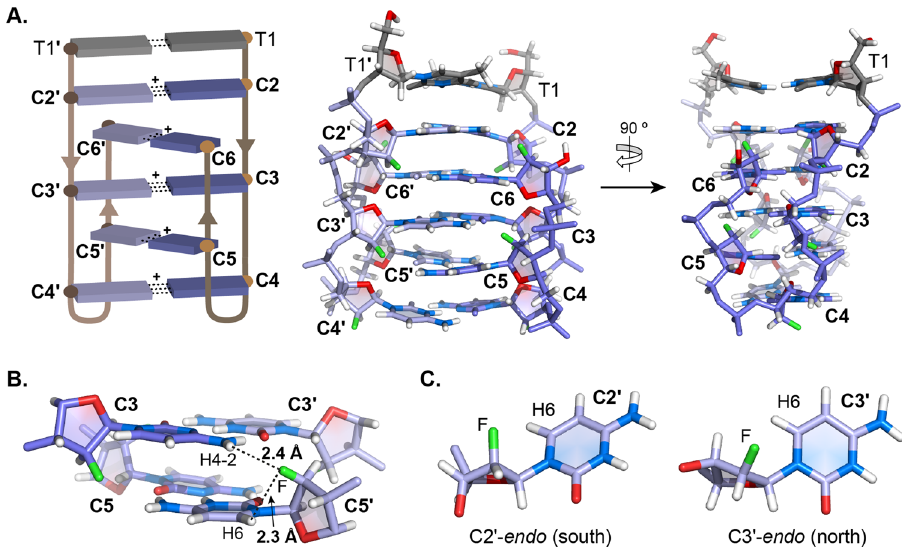
Fig. 4 ON5 dimeric i-motif structural characteristics. A Schematic view (top left), and three-dimensional structure viewed from the major groove (top middle) and minor groove (top, right). B 3 ′ -3 ′ interphase across the major groove showing inter- F···H-amino and intra-residual F···H6 contacts. C Structures of C2 ′ and C3 ′ residues with C2 ′ - endo and C3 ′ - endo sugar pucker, respectively. dT and araF-C are in gray and slate blue, respectively. Atom color code: fl uorine: green; nitrogen: blue; oxygen: red; hydrogen: white. Atom type is not color-differentiated along the backbone. ′ symbols denote residues of the strand with protonated